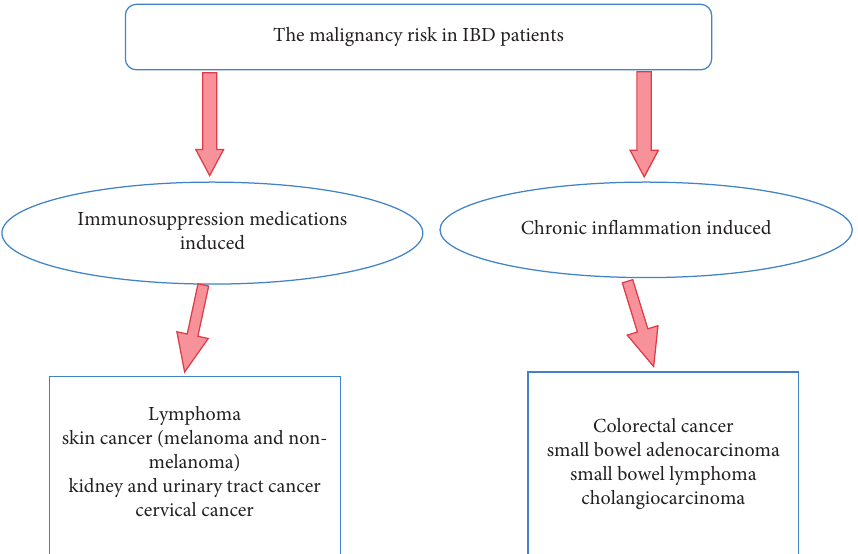
Figure 2: The risk of malignancies in IBD patients and related factors.